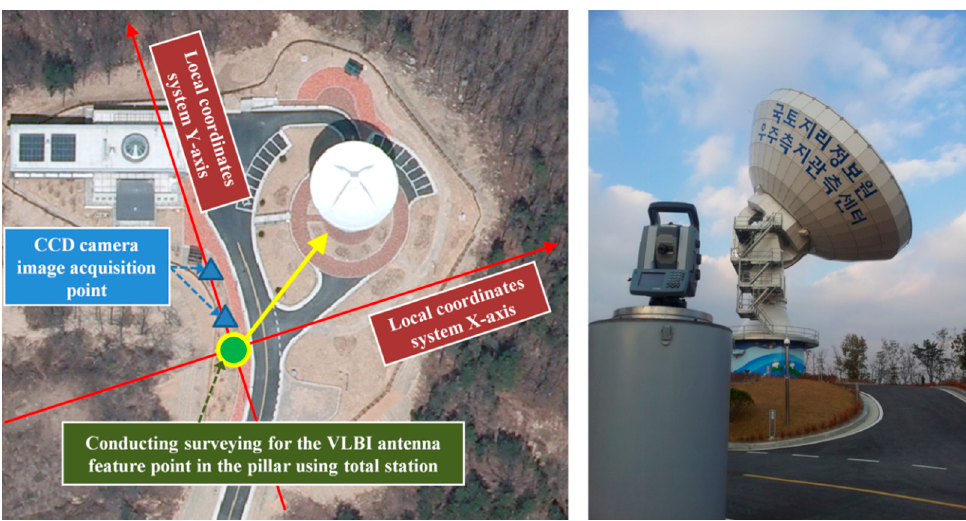
Figure 4. Ground control point survey for the feature points on the VLBI antenna surface.